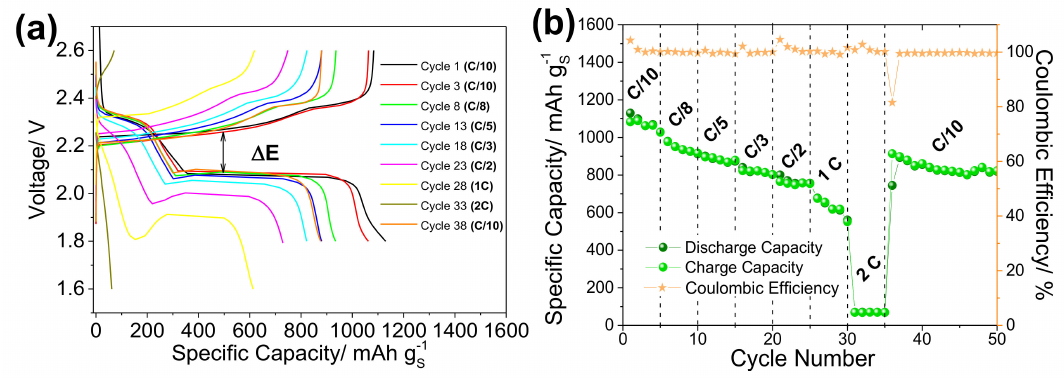
Figure 4. ( a ) Galvanostatic charge / discharge curves at di ff erent rates. ( b ) Rate